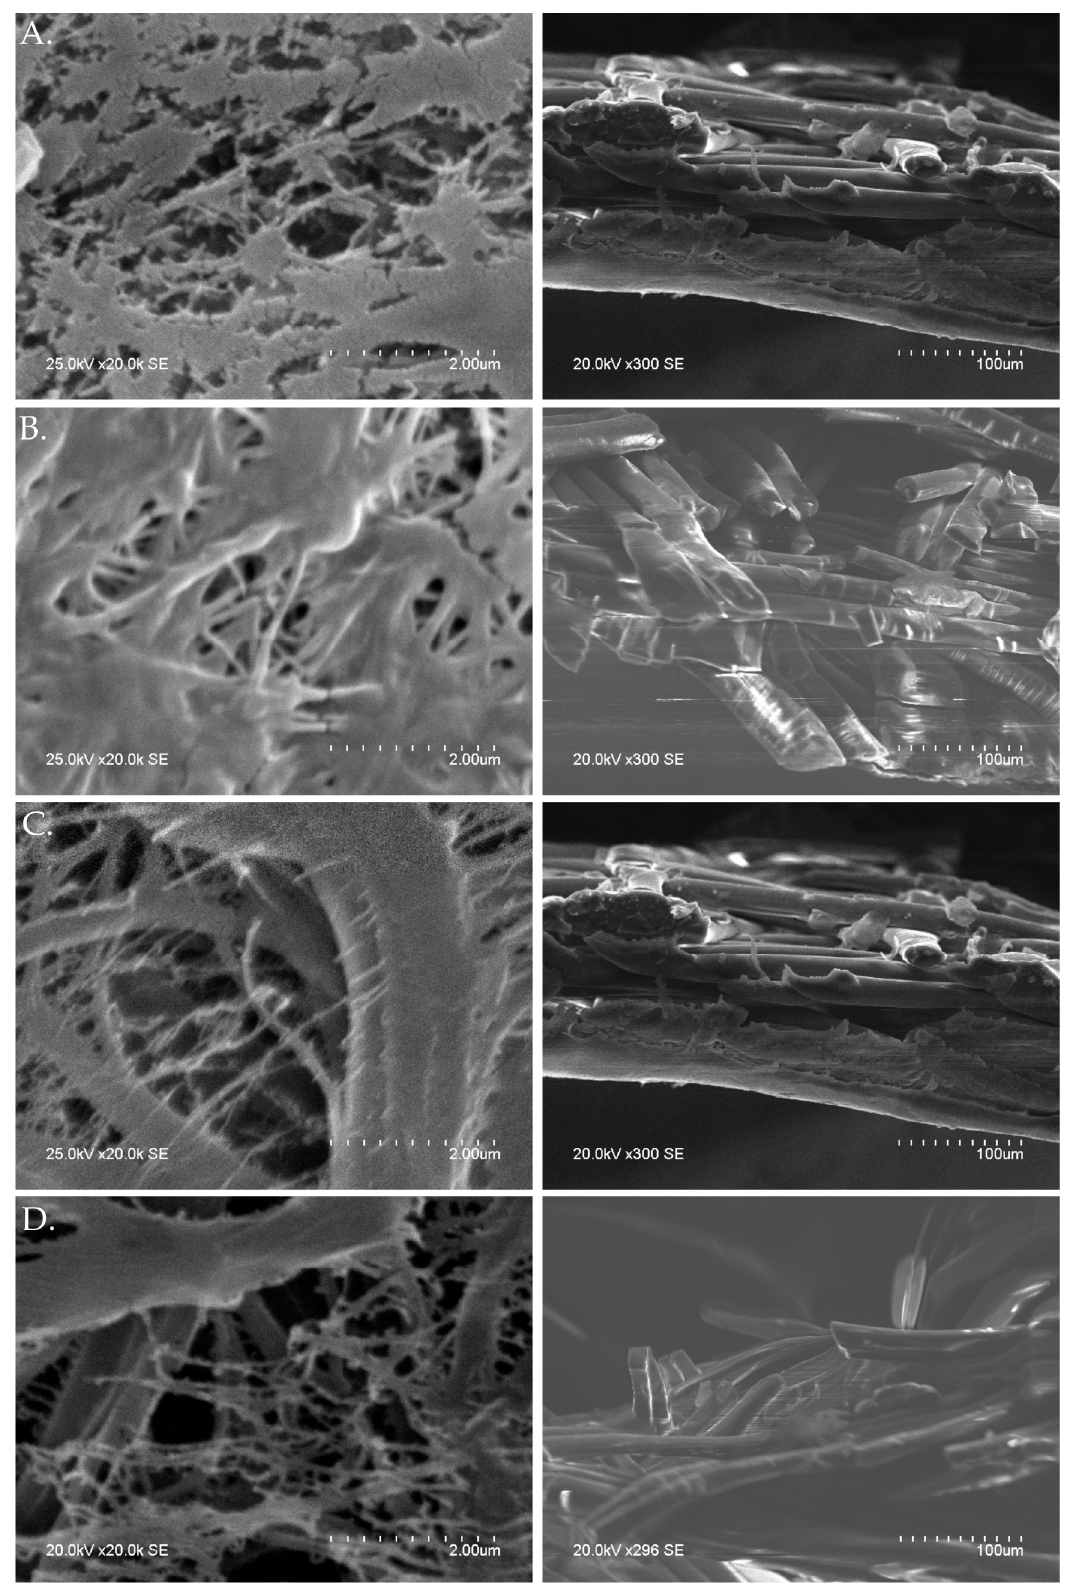
Figure 5. Surface and cross section SEM images for the morphologies of ( A ) PTFE with no RCWW exposure, ( B ) PTFE after 120 min RCWW exposure, ( C ) PP with no RCWW exposure and ( D ) PP after 15 min RCWW exposure.